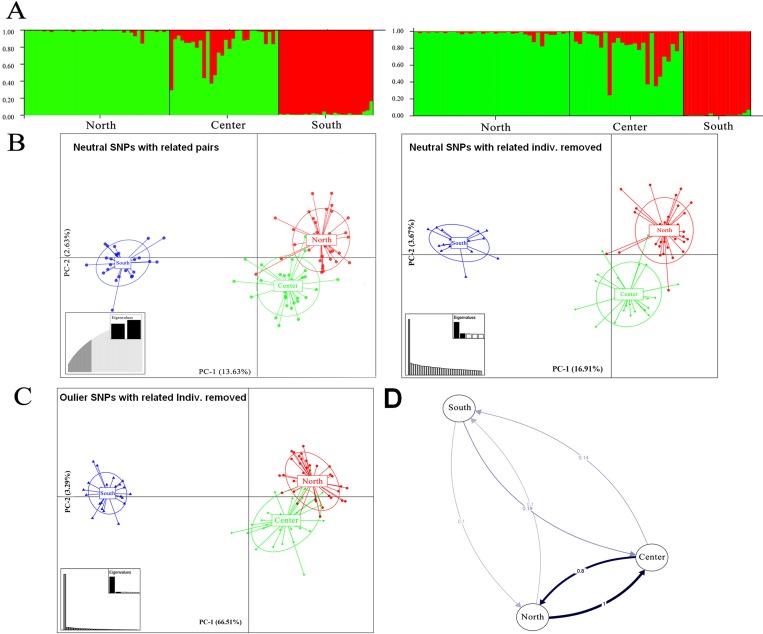
Population structure and migration patterns of Portunus pelagicus along the Vietnamese coastline.The bar plot showing individual assignments to inferred clusters (optimal K = 2) using the neutral SNP panels (A) with related pairs (left) and related individuals removed (right) in the program STRUCTURE. Each genotype is represented by a single vertical bar. Scatter plot from DAPC following two neutral SNP panels (B) and outlier loci (C), the percentage of variability explained by each coordinate is shown in brackets. The directional relative migration calculated by the divMigrate function performed in the R package diveRsity (D).